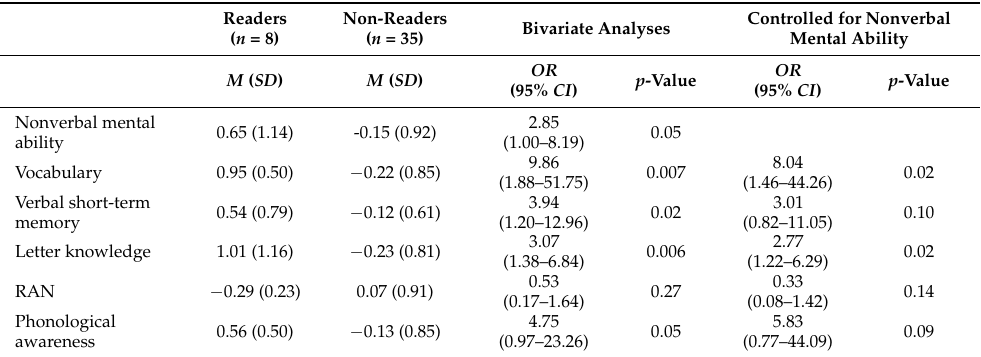
Table 3. Mean standardized ( Z ) scores ( SD ) and OR for the cognitive measures at T1 of readers vs. non-readers at